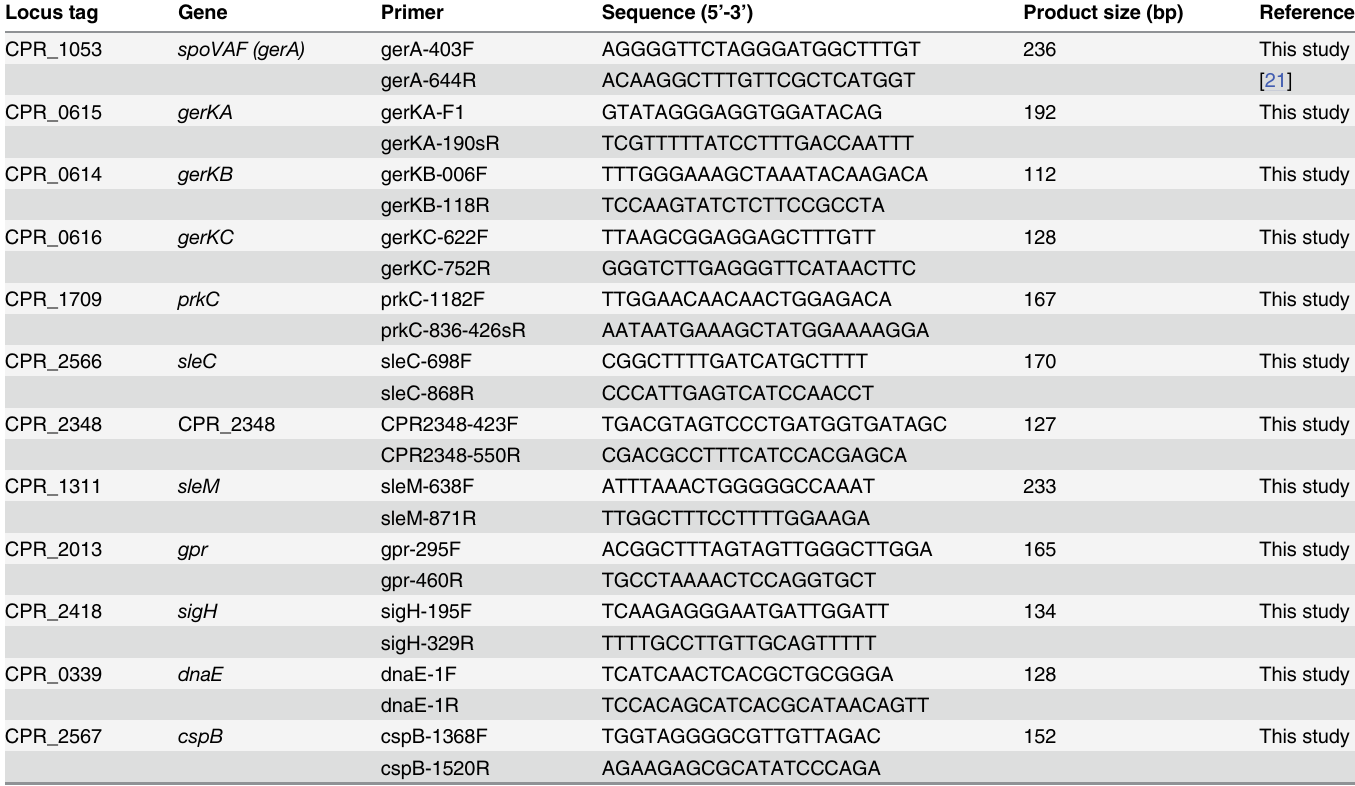
Table 1. Primers for RT-PCR used in this